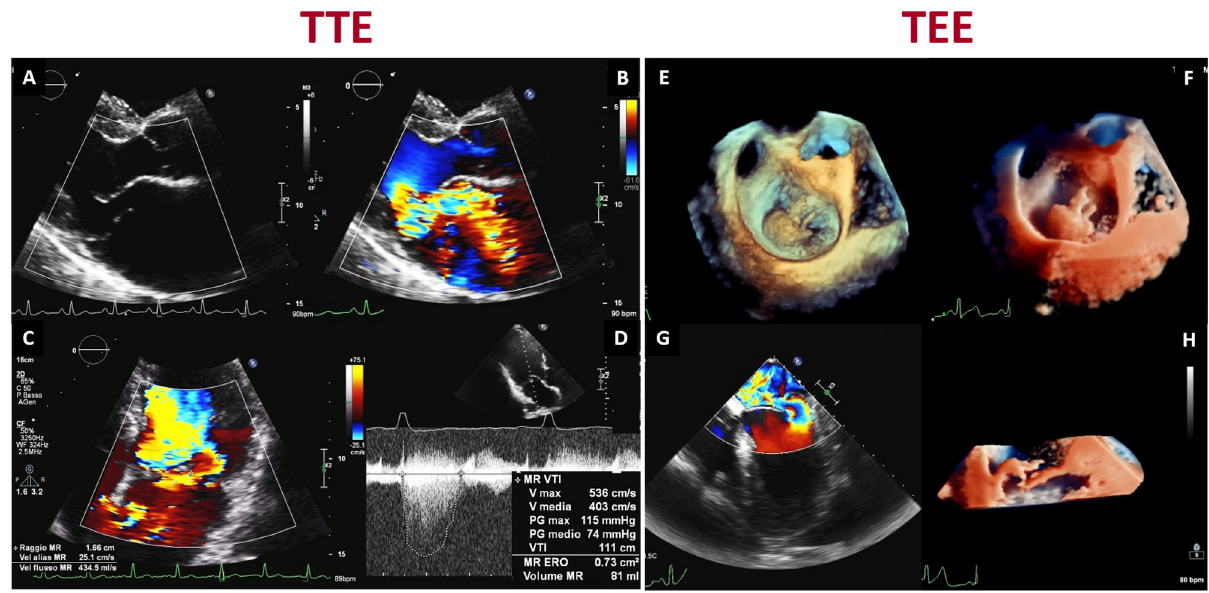
Figure 2. Transthoracic ( left ) and transesophageal ( right ) echocardiographic evaluation of a patient with mitral valve prolapse and severe mitral regurgitation: ( A ) parasternal long-axis view demon- strating a flail of the posterior mitral valve leaflet (scallop P2); ( B , C ) assessment of the regurgitant jet by color flow Doppler in parasternal long-axis and apical four chamber views; ( D ) continu- ous wave Doppler measurement of mitral regurgitation peak velocity and time–velocity integral; ( E ) standard 3D TEE rendering of the mitral valve in a surgical view; ( F ) transillumination rendering technique with a virtual light source highlighting the localization of the chordal rupture; ( G ) 2D color Doppler image of the eccentric regurgitant jet, known as the Coand ă effect, hugging the interatrial septum; ( H ) 3D transillumination rendering image cropped at A2-P2 showing the flail of the posterior mitral